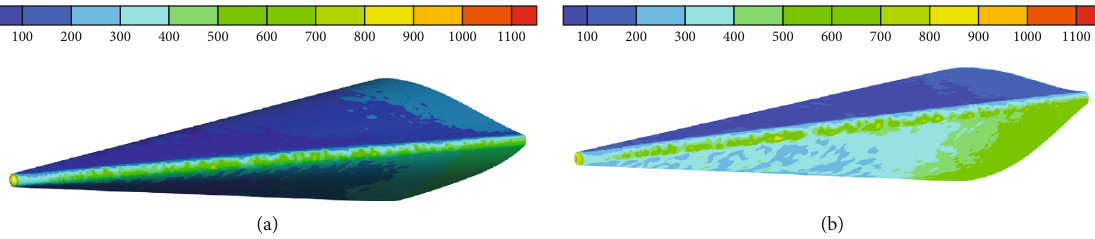
Figure 11: Shear stress distribution on the surface: (a) the baseline and (b) the optimum.